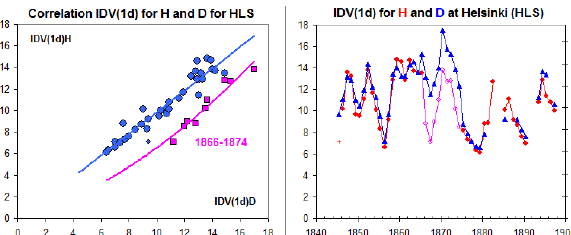
Figure A3. Using s(D) and s(H) we can calculate the corresponding IDV(1d) values for HLS (right-hand panel). There is generally a good agreement between values derived derived using s(H) and s(D) , except for the interval 1866–1874 for s(H) as also shown in the left-hand panel, plotting IDV(1d) derived from s(H) against IDV(1d) derived from s(D) . Pink symbols are for 1866–1874 while blue symbols are for data outside of that